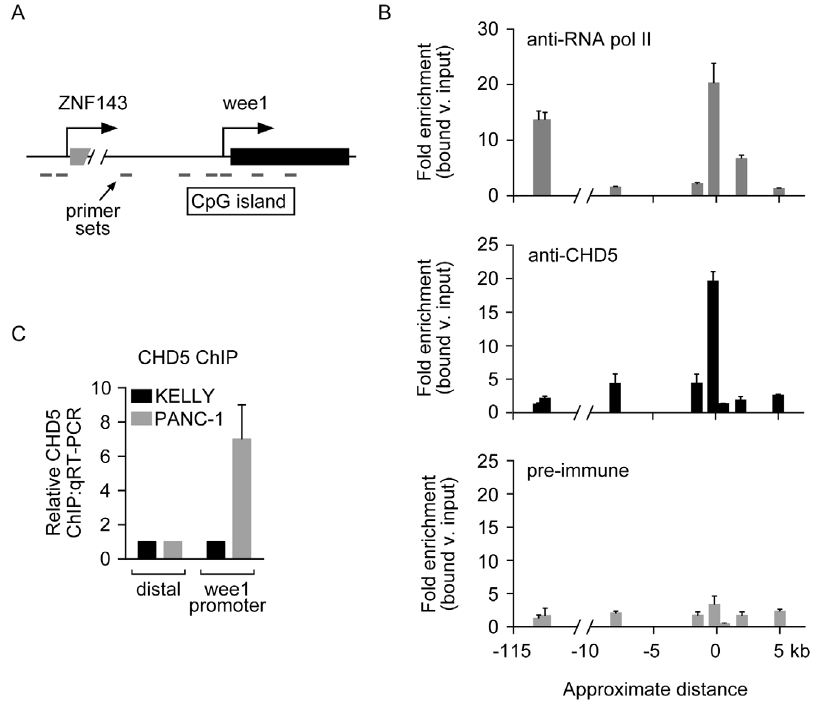
Figure 3. CHD5 is enriched at the WEE1 promoter. (A) Schematic of the WEE1 locus with the putative WEE1 promoter and direction of transcription indicated. The promoter of the ZNF143 gene is approximately 115 kb upstream of WEE1 . The horizontal bars depict the location of primersets used. (B) ChIP experiments using anti-RNA pol II antibodies show enrichment of RNA pol II at both WEE1 and ZNF143 promoters. ChIP experiments using anti-CHD5 sera indicate the enrichment of CHD5 at the WEE1 promoter but not the ZNF143 promoter. As a negative control, ChIP experiments using pre-immune sera (pre-IgG) were performed and show no specific enrichment patterns. Values shown indicate bound v. input signals normalized to a distal intergenic region. (C) As a negative control, ChIP experiments were performed using anti-CHD5 sera and chromatin from KELLY cells (CHD5-negative). No enrichment was observed at the WEE1 promoter using KELLY cells. Error bars represent SD [n=3].